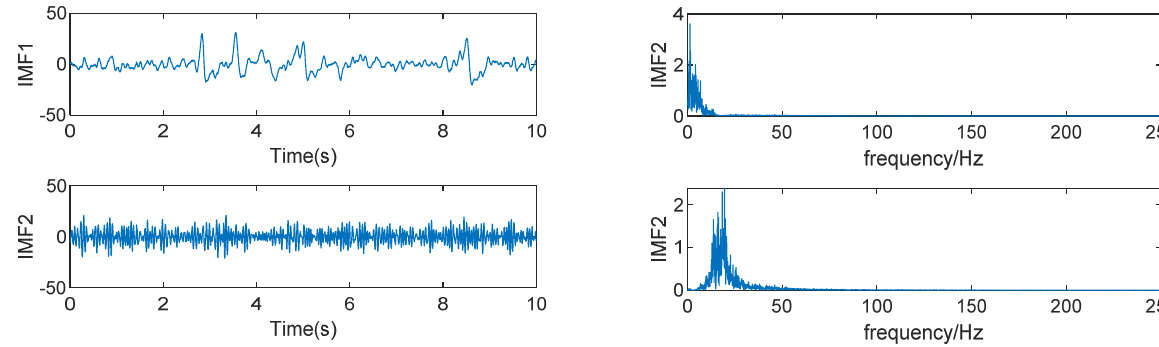
Figure 6. VMD decomposition result of K = 2.